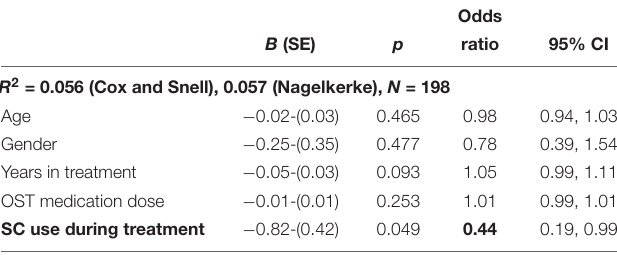
TABLE 9 | A logistic regression model to predict treatment